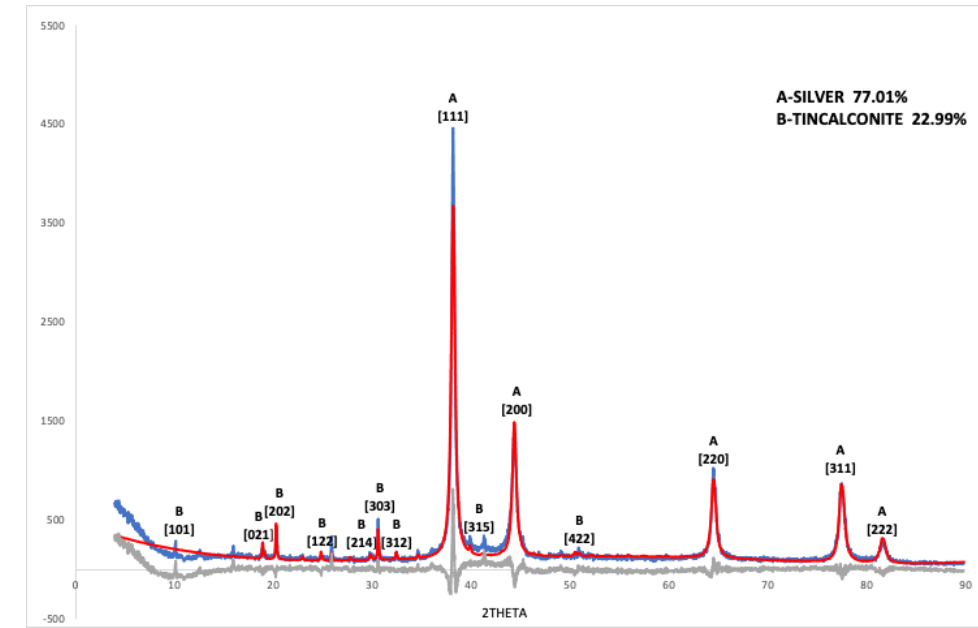
Figure 1. XRD measurements of powders obtained by precipitation from the aqueous dispersion (blue) and Rietveld refinement (red). Difference (Measured pattern — Rietveld refinement) (grey).